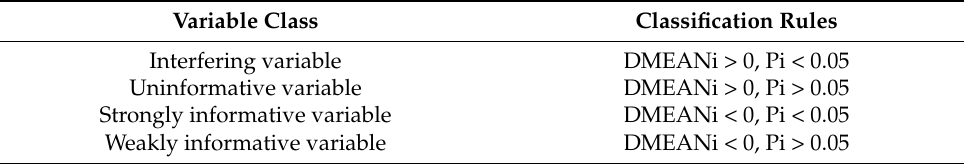
Table 2. Variable classification rules of iteratively retains informative variables (IRIV)